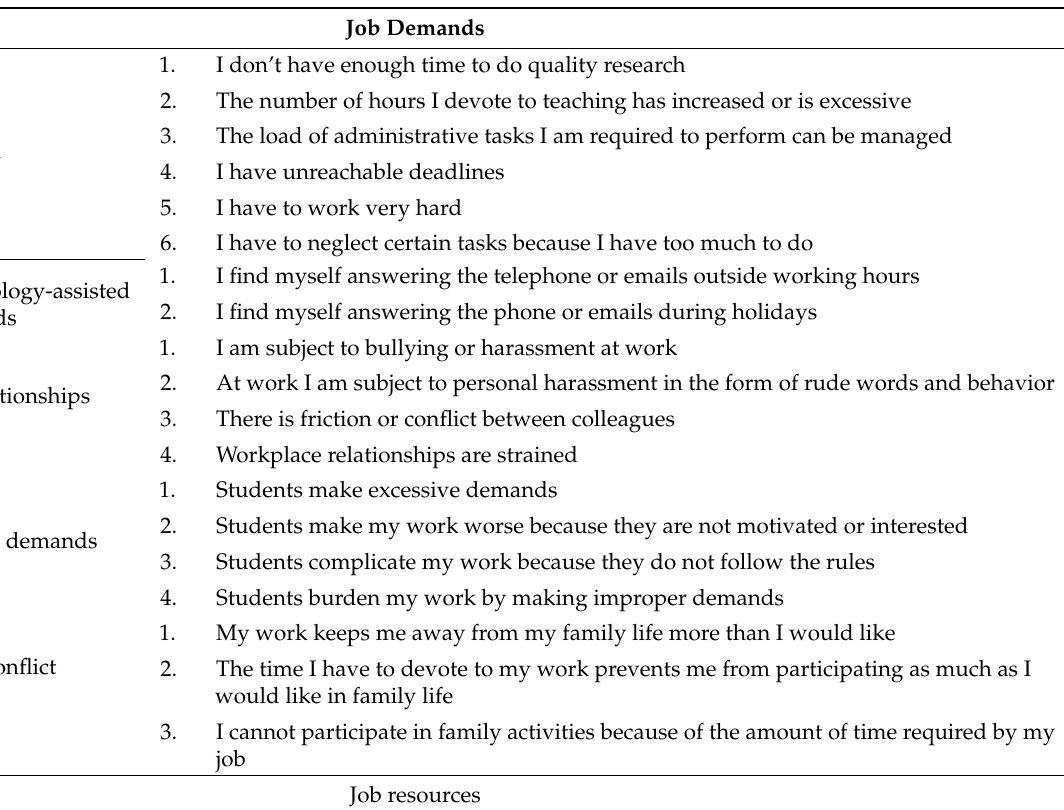
Table A1. The final 72 items of the AQ@workT